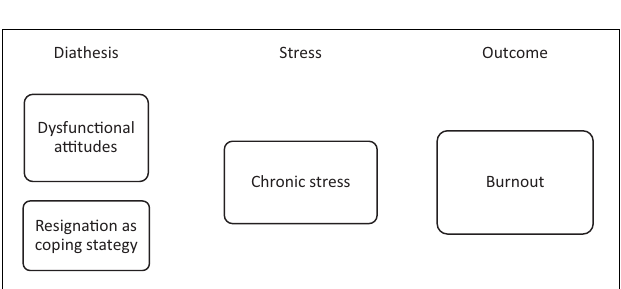
FIGURE 2 | Sport-specific diathesis stress model for